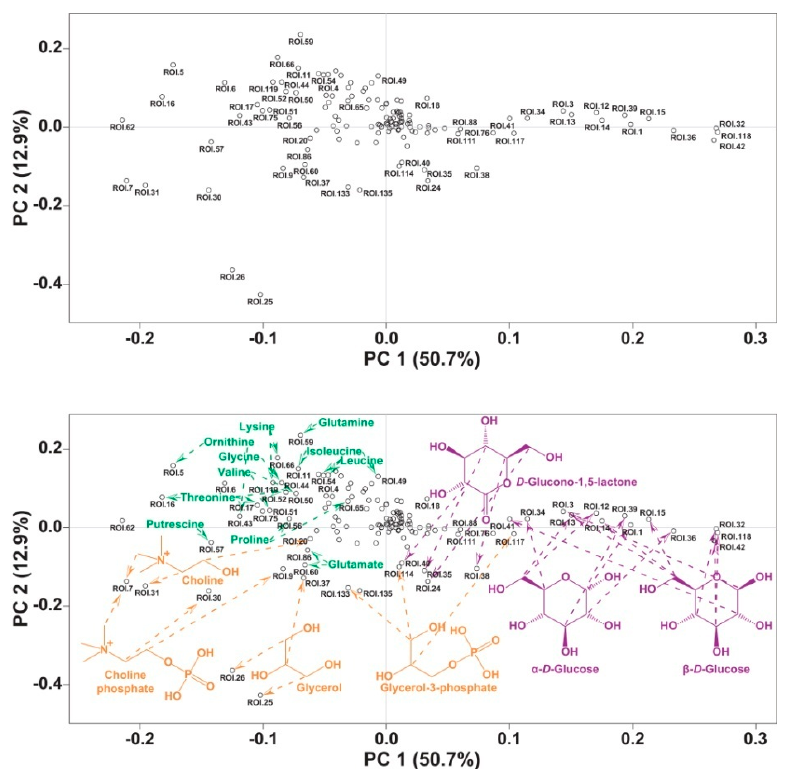
Figure 3. PCA-loading plot of 1 H- 13 C HSQC ROIs. Upper panel: Raw loadings chart; Lower panel: structures of identified metabolites were added. Notice that in several cases a single metabolite produced multiple ROIs.